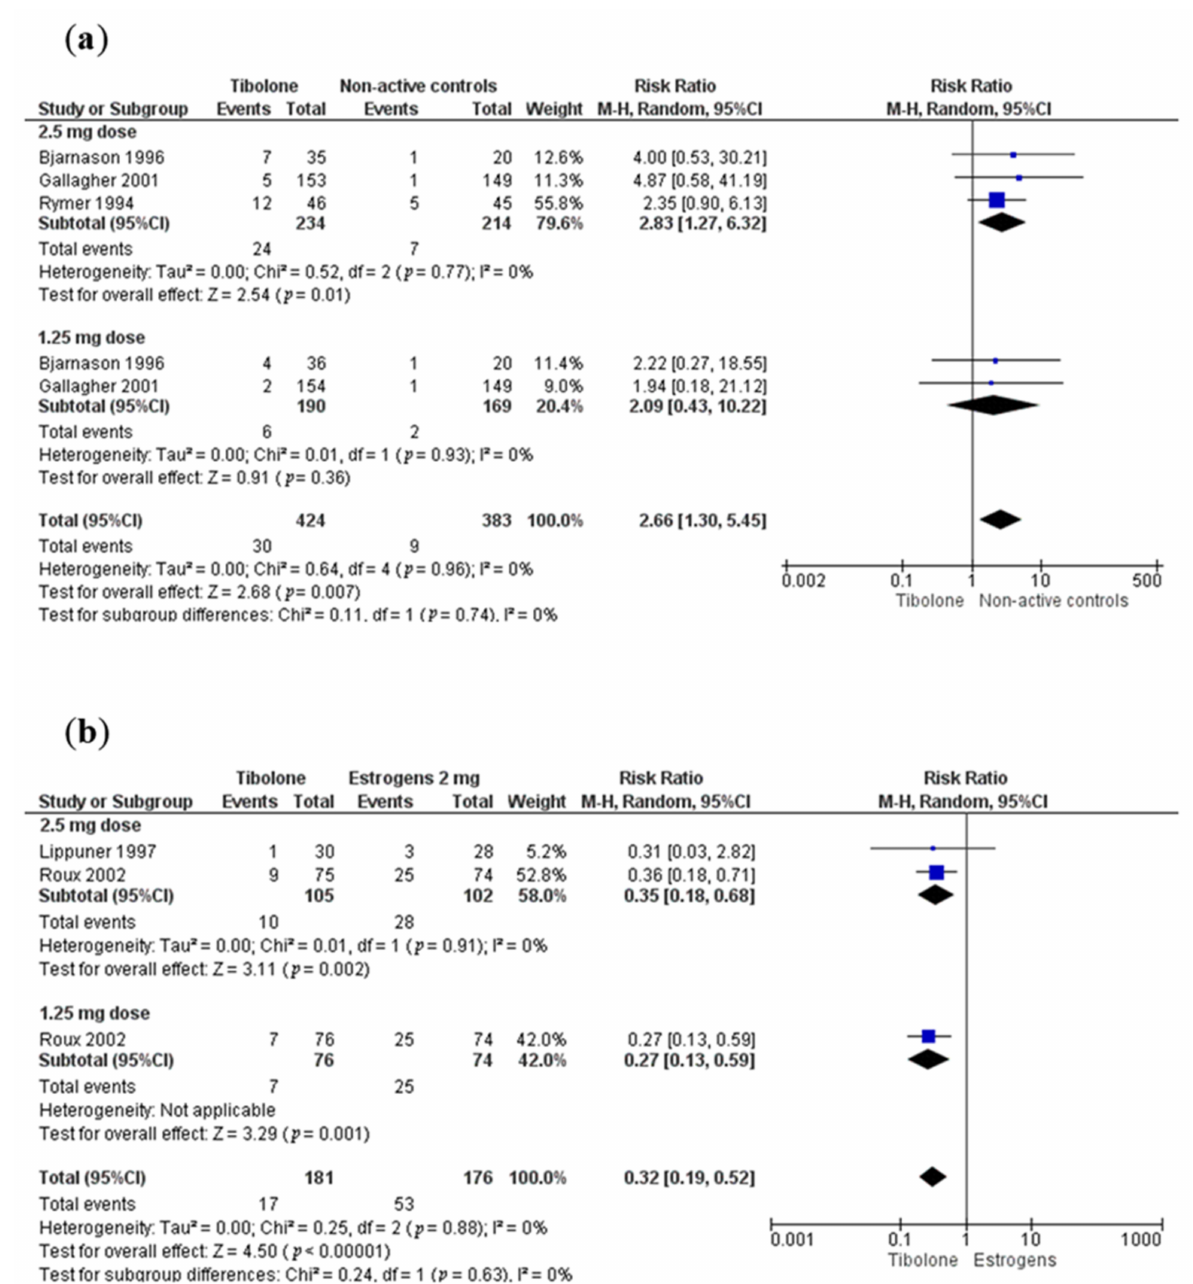
Figure 4. Forest plot of vaginal bleeding. ( a ) Tibolone versus non-active controls, ( b ) Tibolone versus estrogens (2